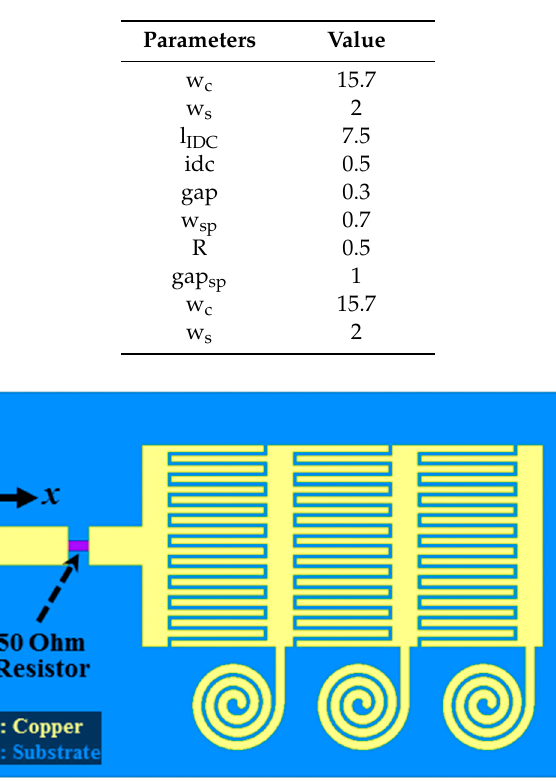
Table 3. Parameters of the CRLH TL unit cell.